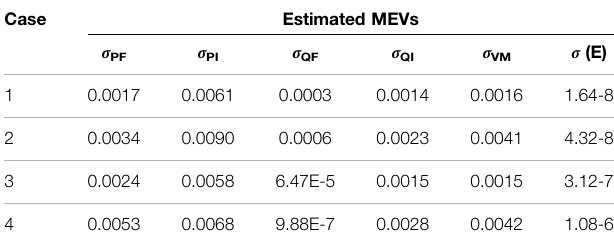
TABLE 3 | Estimated MEVs of the IEEE 14-bus system ( N LME = 3).